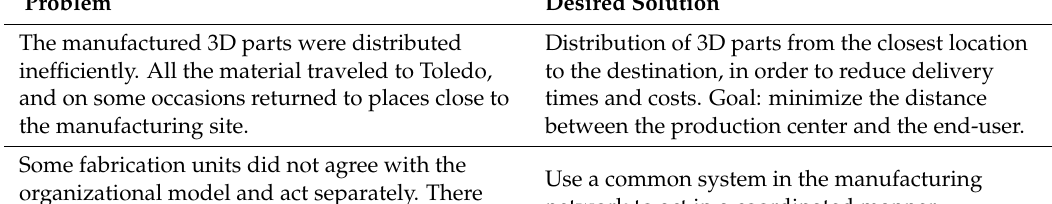
Table 2. Problems derived from the initial management